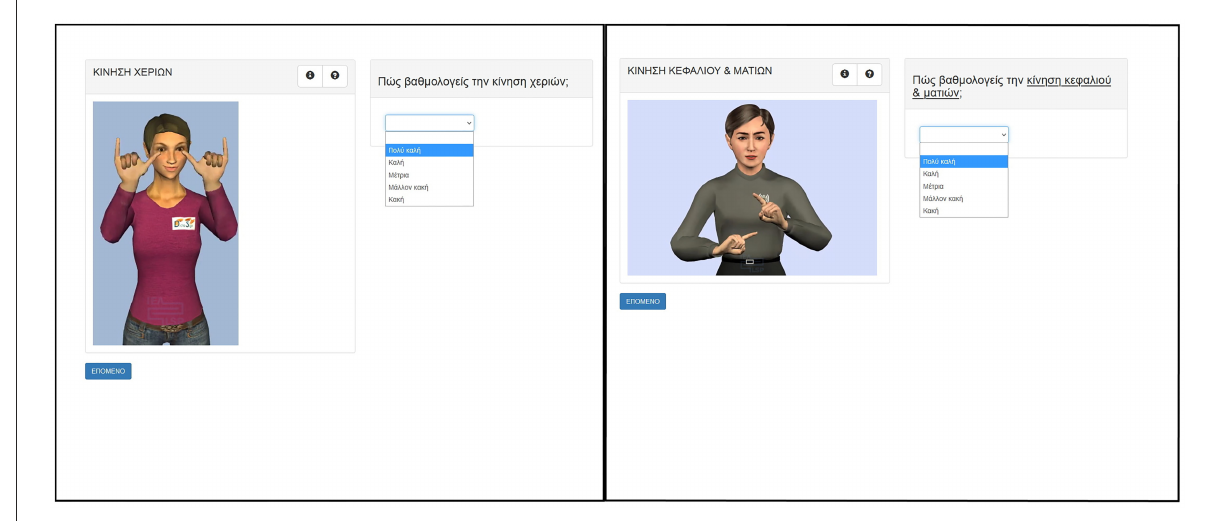
FIGURE3 Performance observation and ranking in different screens for Françoise (picture on the left) and Paula (picture on the right) avatars in Part B of the questionnaire.